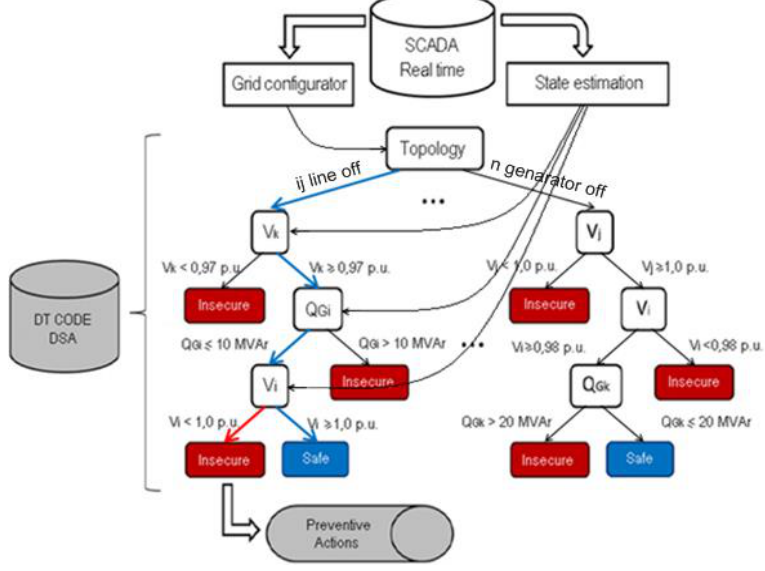
Figure 6. Real-time step scheme dynamic security assessment module based on decision tree.